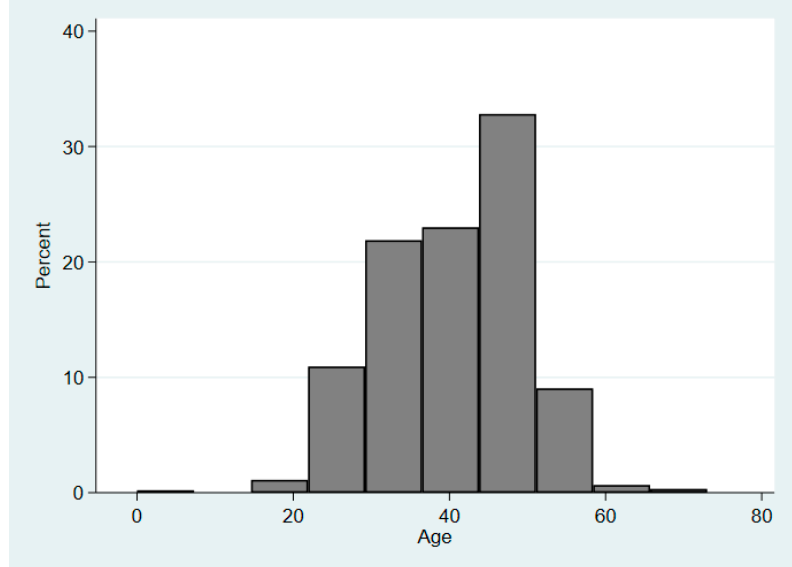
Figure 1. The combined age distribution of firefighters from fire department 1 (western U.S.) and fire department 2 (eastern U.S.).